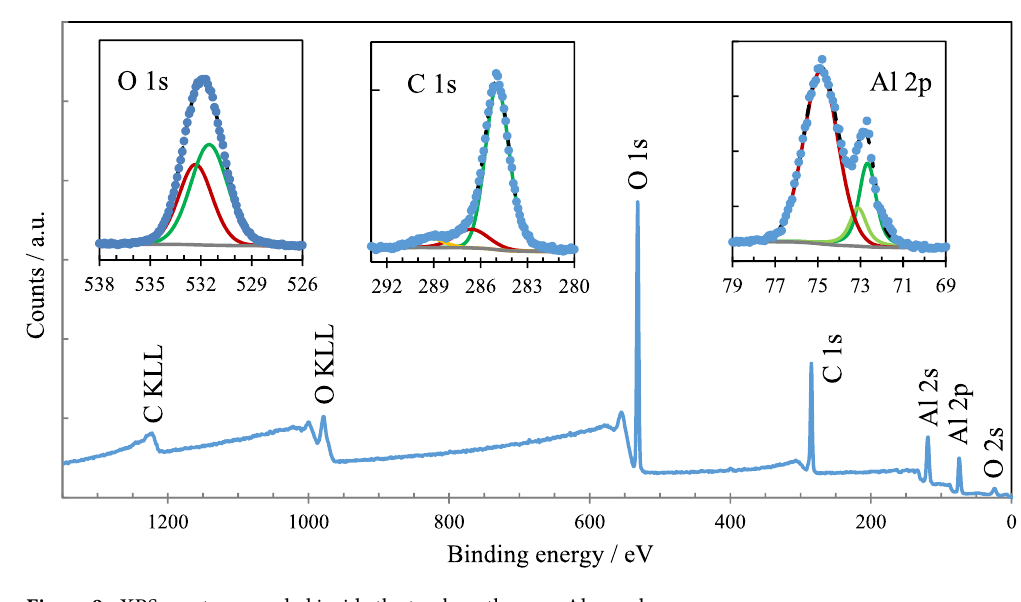
Figure 9. XPS spectra recorded inside the track on the pure Al